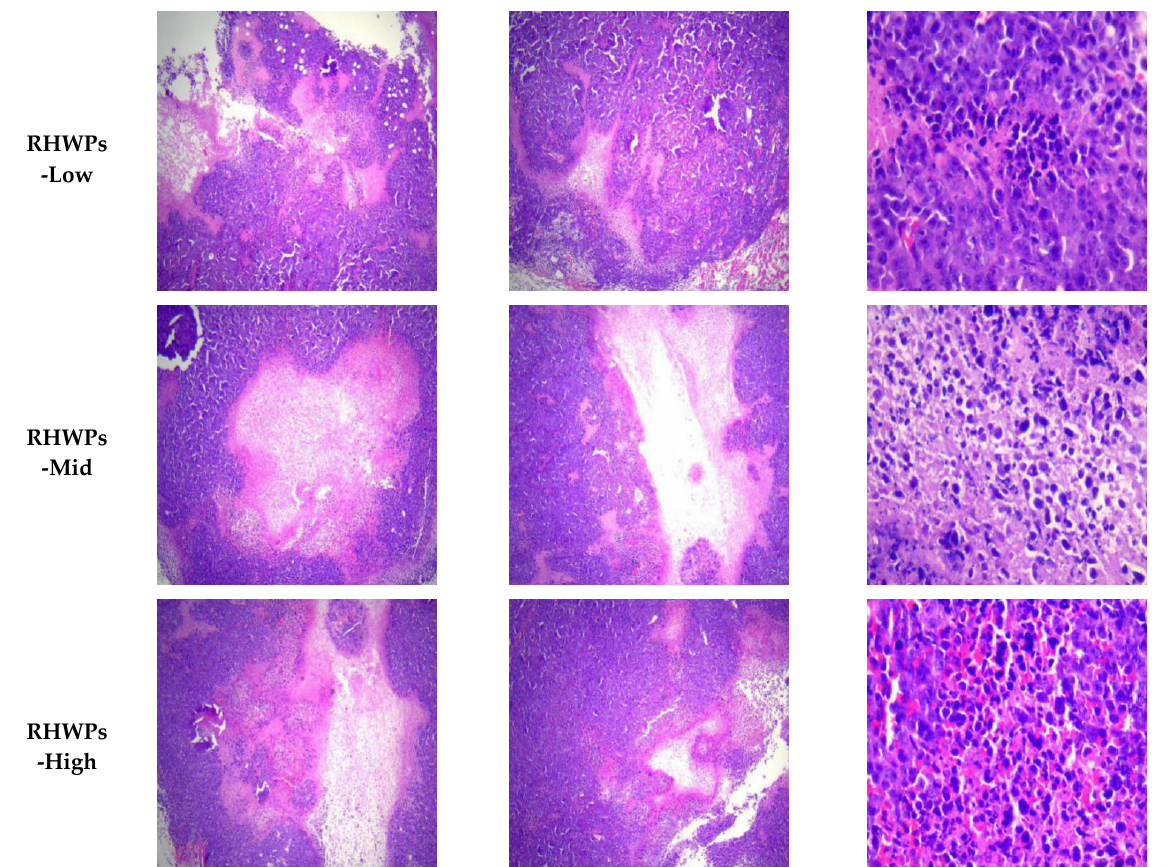
Figure 6. Representative images of H&E-stained tumor tissues of the indicated groups. Tumor tissue of different groups were collected 24 h after the last drug administration in order to investigate tumor tissue changes. The tissue sections were stained with hematoxylin and eosin and observed under a light microscope (UOP, USA) at 100× and 400× magnification to record the pathological changes. Different degrees of hyperplasia were found in different groups.